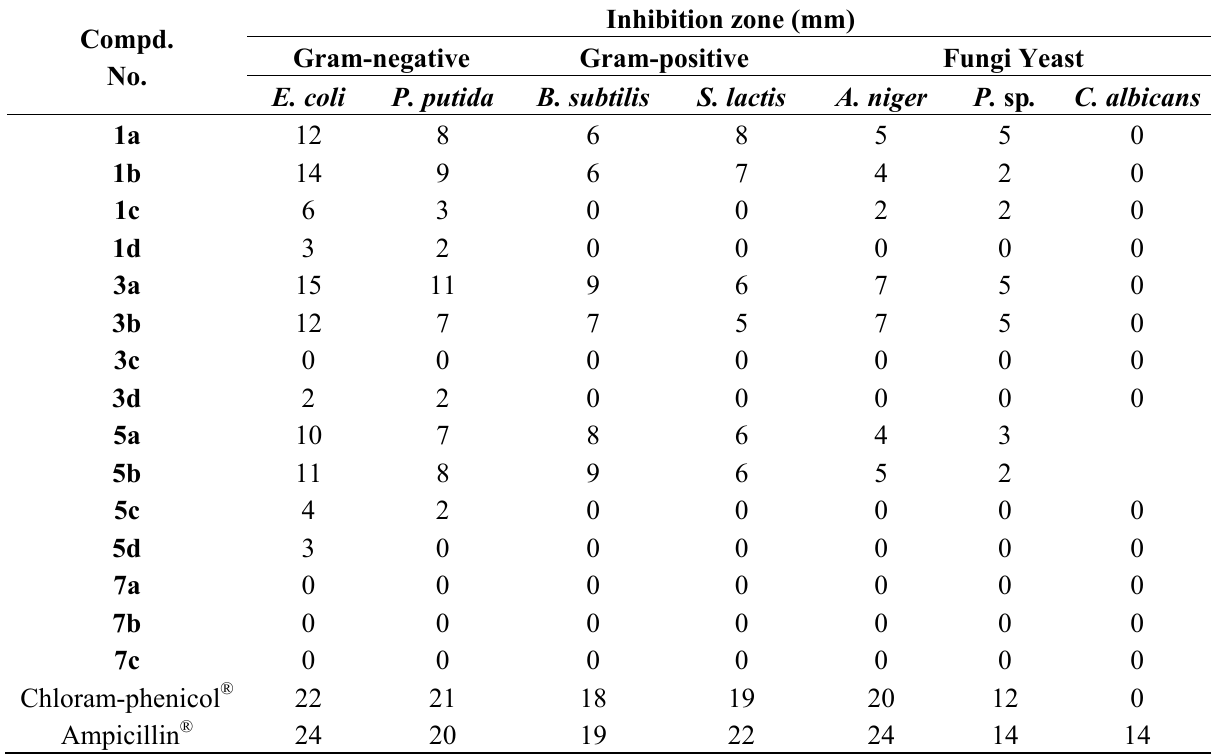
Table 5. Antimicrobial activities of the newly synthesized